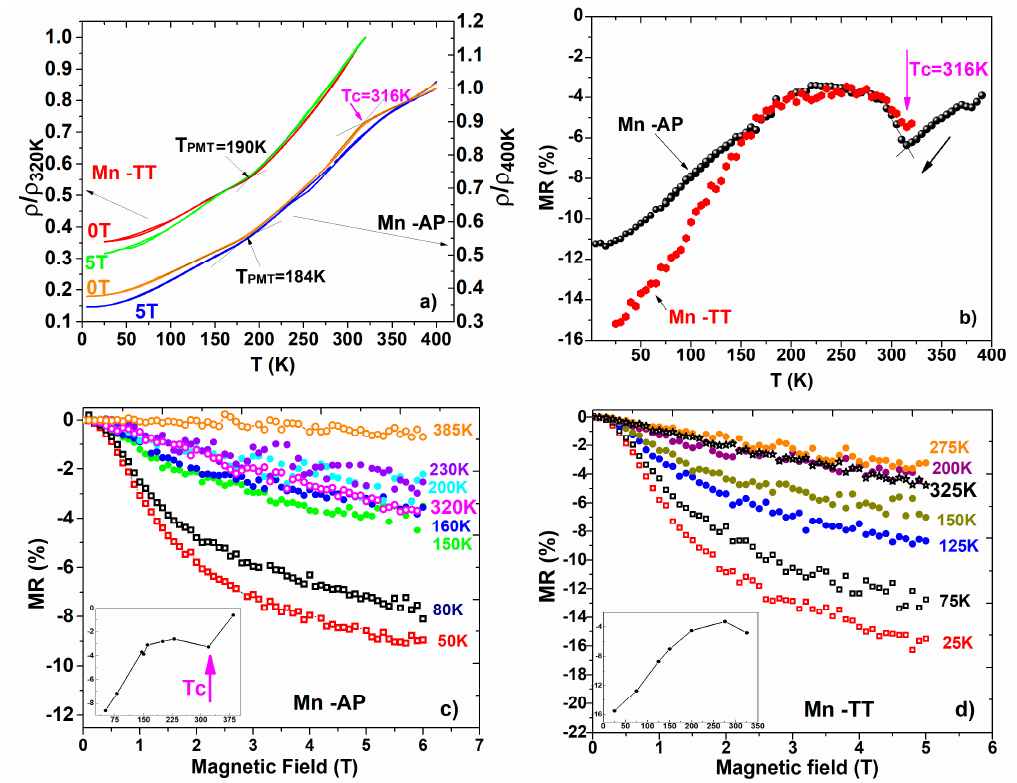
Figure 6. ( a ) Reduced resistivity versus temperature in 0 and 5 T; ( b ) evaluation of MR% from temperature dependence of Ac resistivity ( ρ ) for samples Mn-AP and Mn-TT; ( c ) resistivity change under applied magnetic field at different temperatures for Mn-AP and ( d ) for Mn-TT samples. Insets: shows the temperature dependence of MR% at 5 T field obtained from MR(H) dependency.